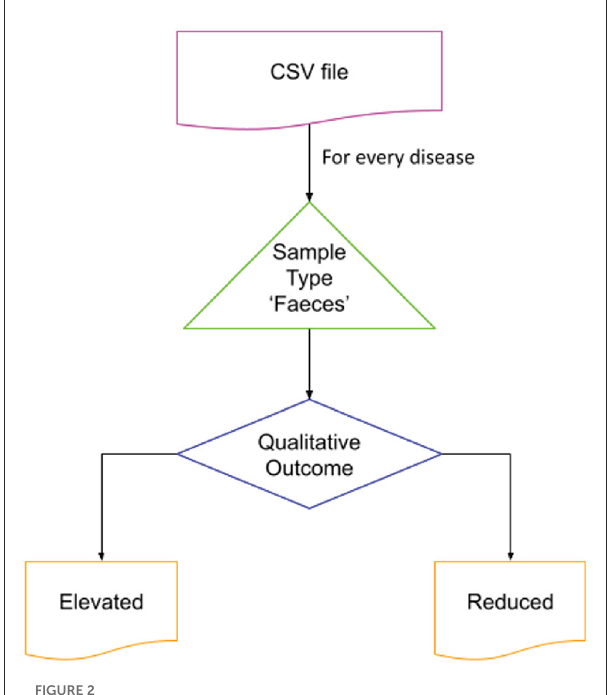
FIGURE2 Extraction of microbial dysbiosis data from Disbiome database. The flow was iterated over the disease of interest for the sample type “Feces." The list of elevated and reduced organisms reported was stored in separate files for further